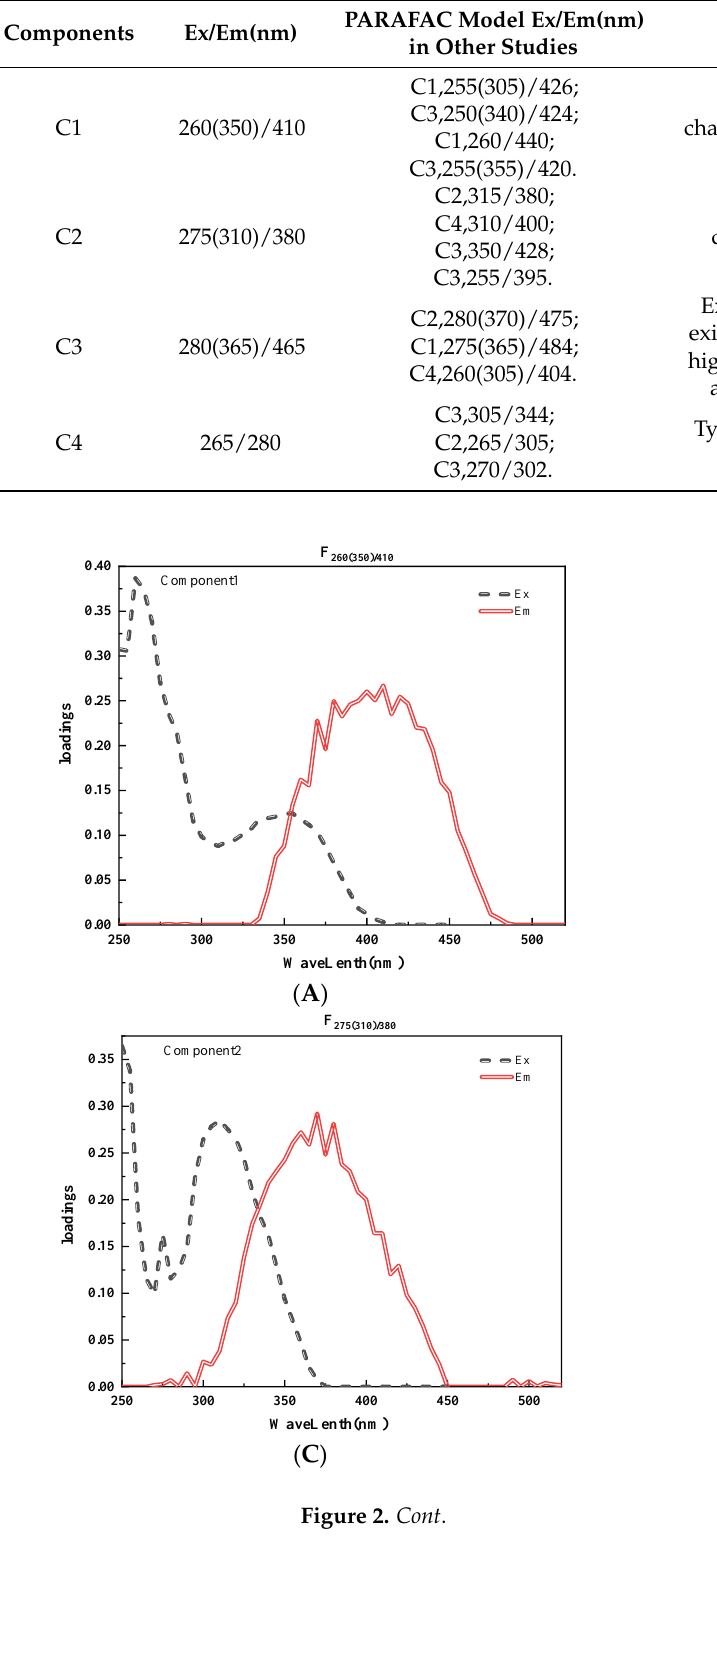
Table 3. Comparison table of PARAFAC model components.